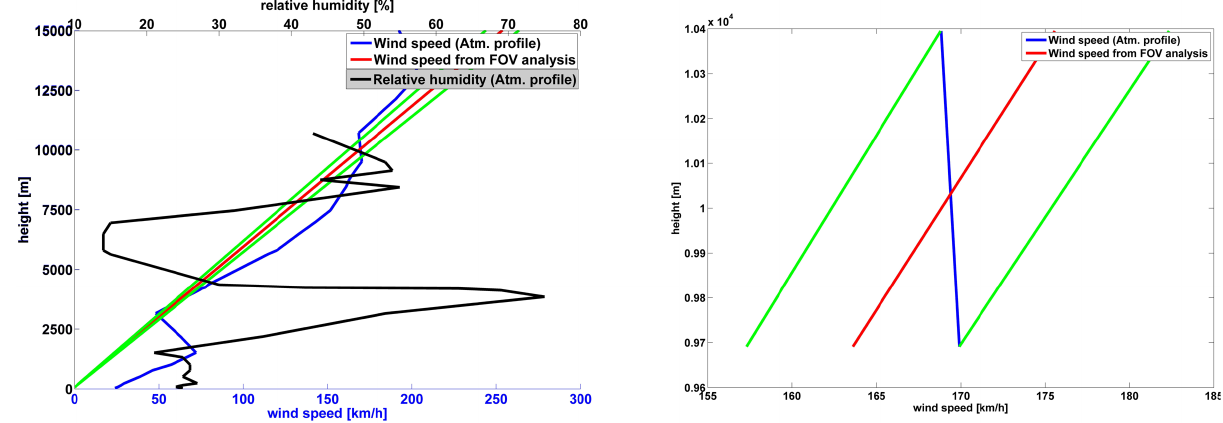
Fig. 9. Left: crossing measured wind velocity (blue line) with hypothesized possible wind velocities from FOV analysis (red line with green error lines). Notice the crossing points correspond to a high humidity layer (black line). Right: Enlargement on the top crossing point.